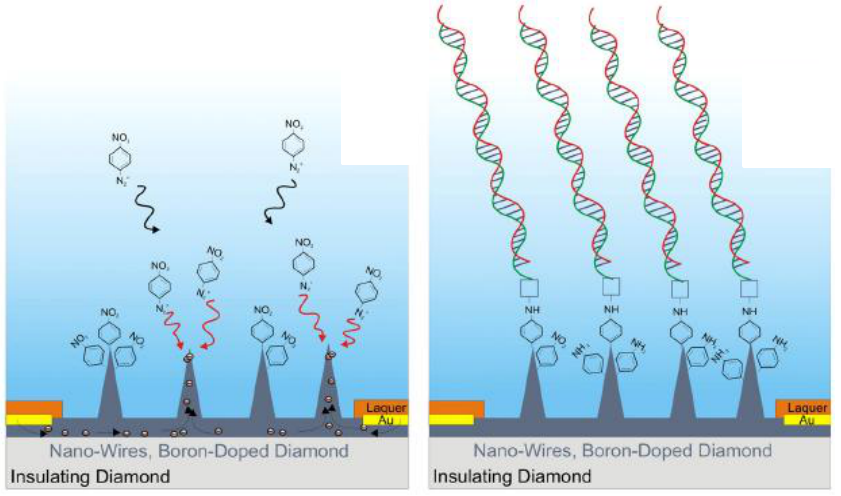
Figure 8. Diamond nanowires for DNA sensing: Preferential linking of phenyl aryl and DNA molecules to the tip of the wires (reprint with permission from